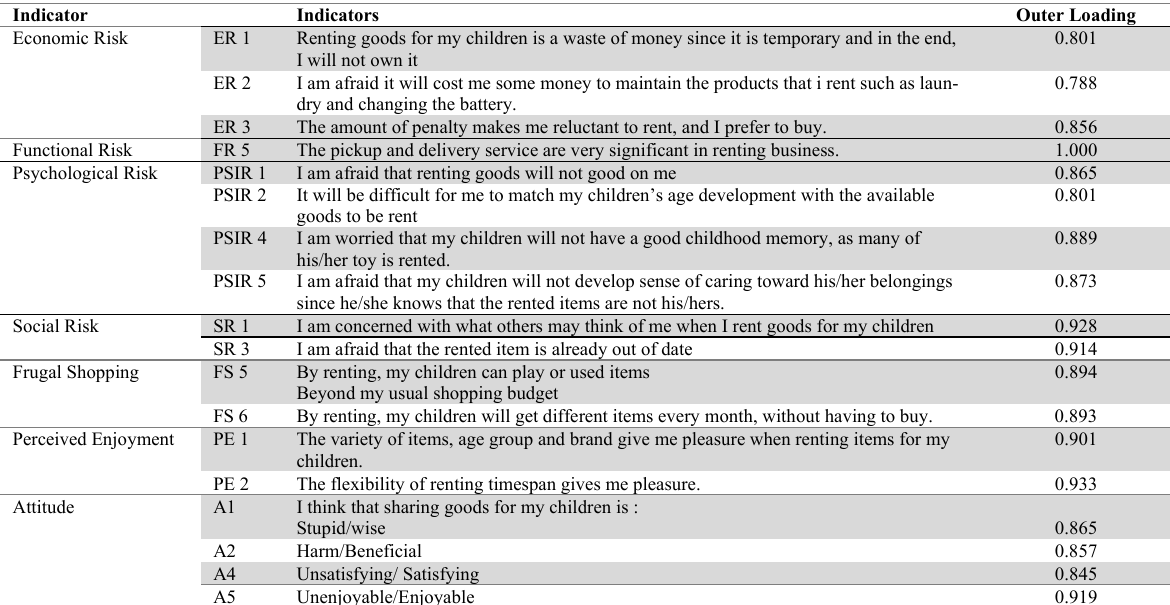
Research Model Measurement Renter